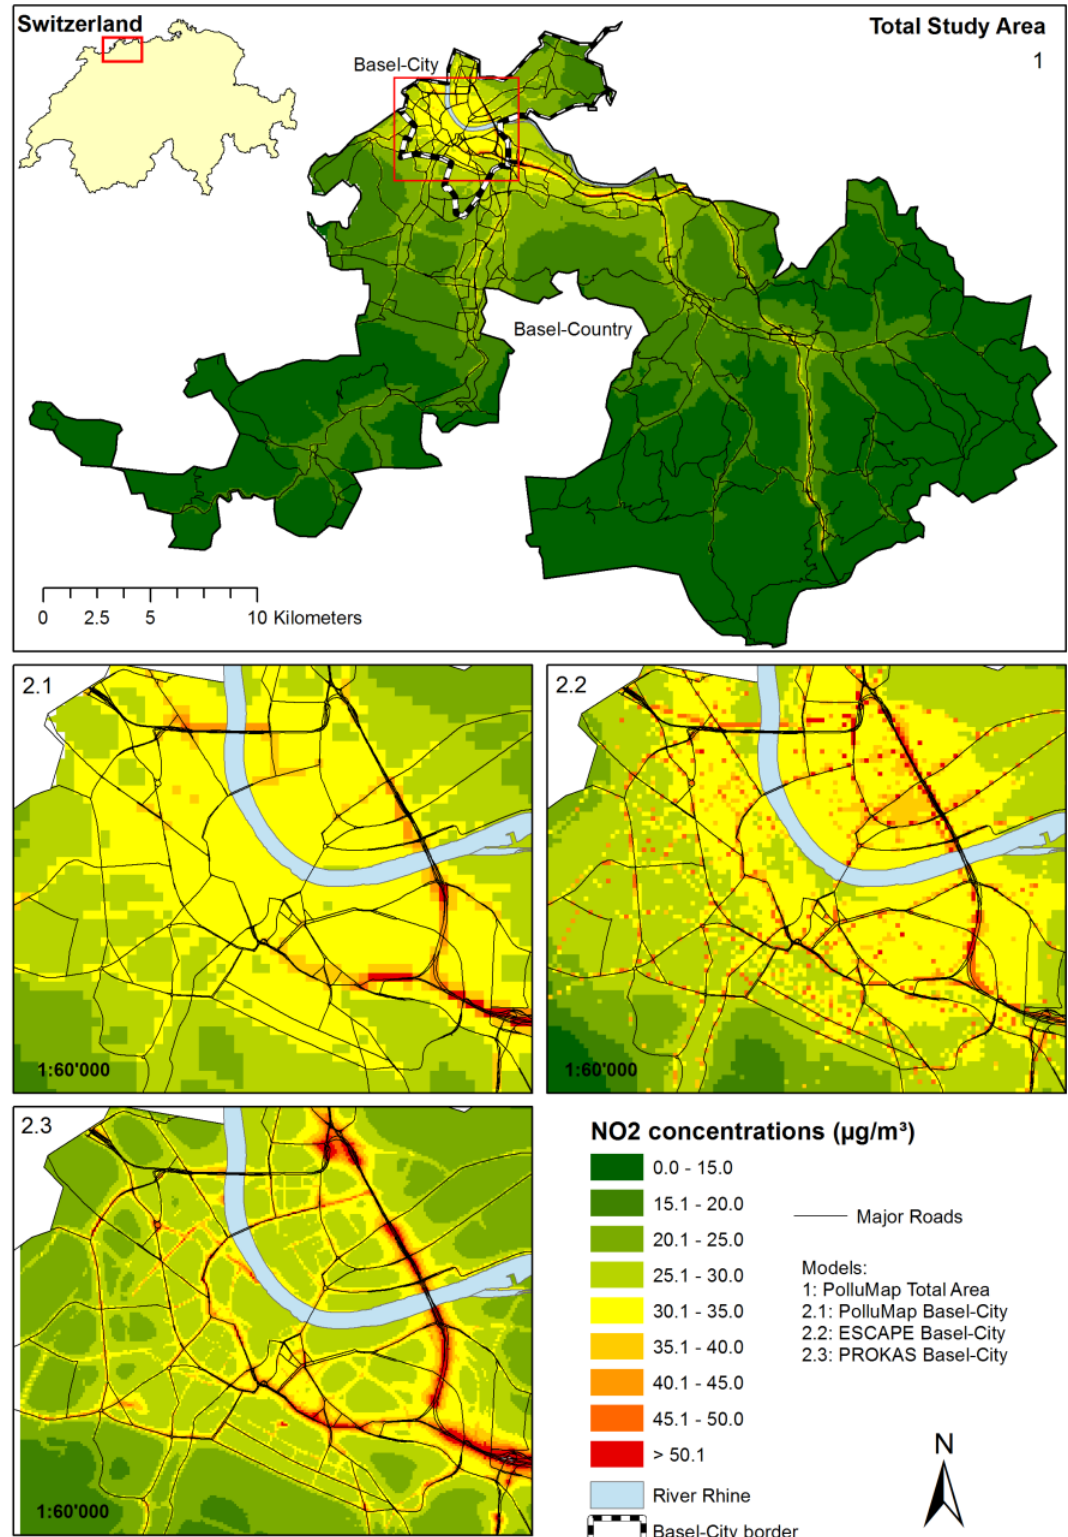
Figure 1. Annual mean NO concentrations from different air pollution models for total 2 study area ( 1 ); and Basel-City ( 2